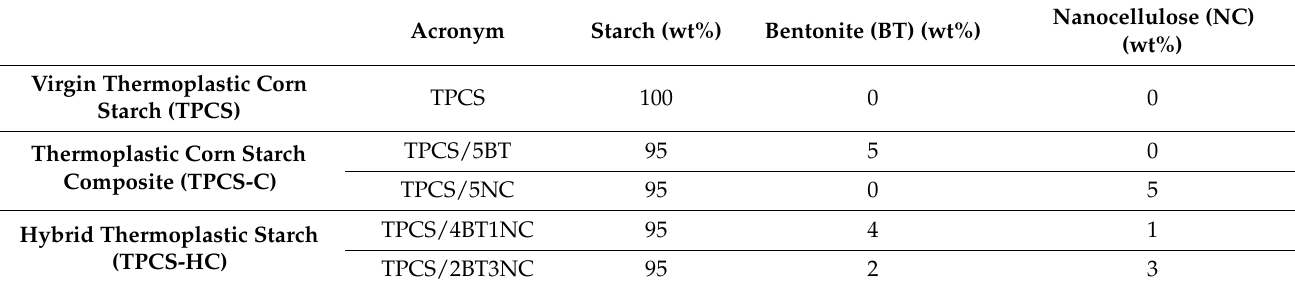
Table 1. The formulation of TPCS, TPCS-C, and TPCS-HC